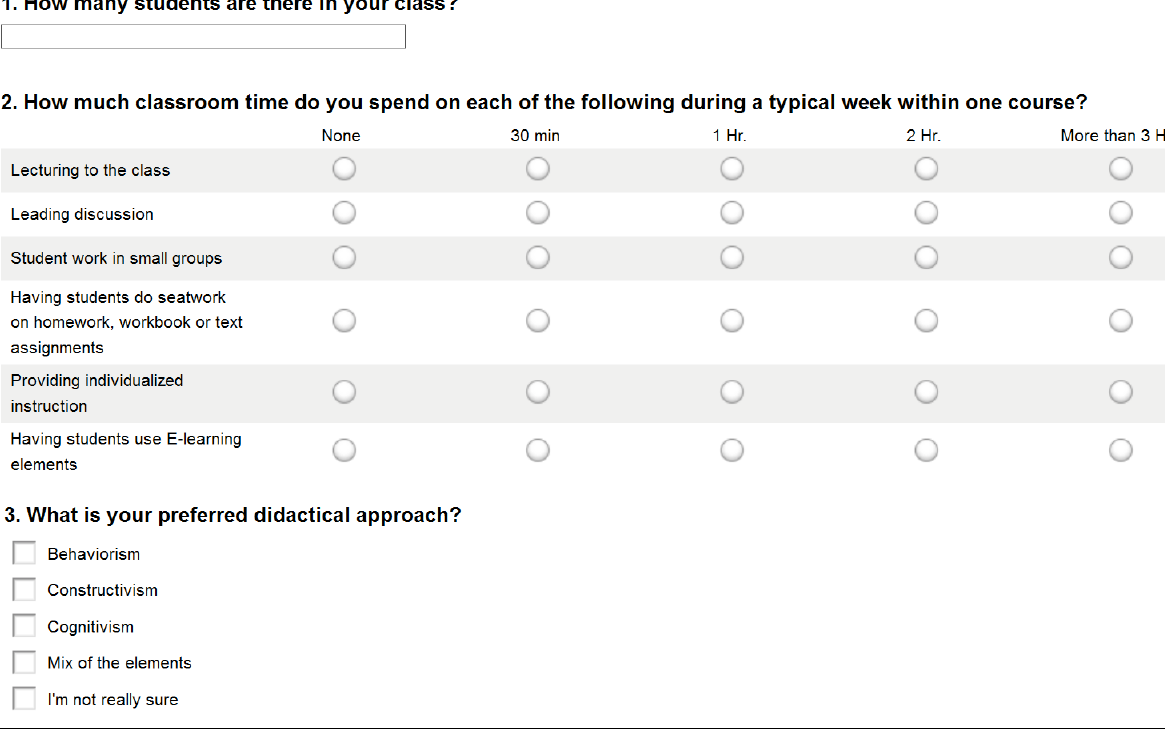
Figure 2. Screenshot for the requirements collection